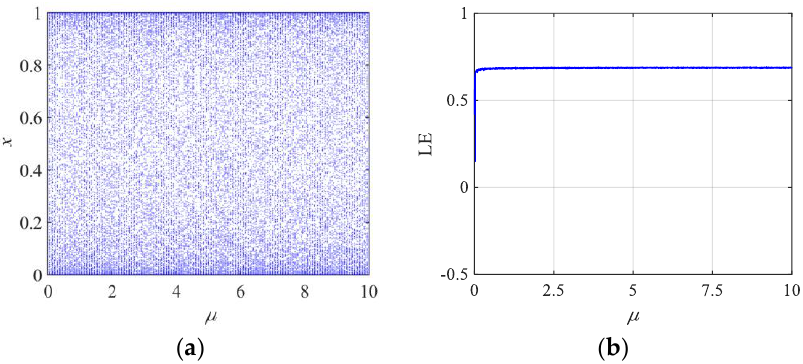
Figure 2. Bifurcation diagram and Lyapunov exponent graph of system (1): ( a ) Bifurcation diagram of system state quantity versus parameter µ ; ( b ) The graph of Lyapunov exponent versus parameter µ .